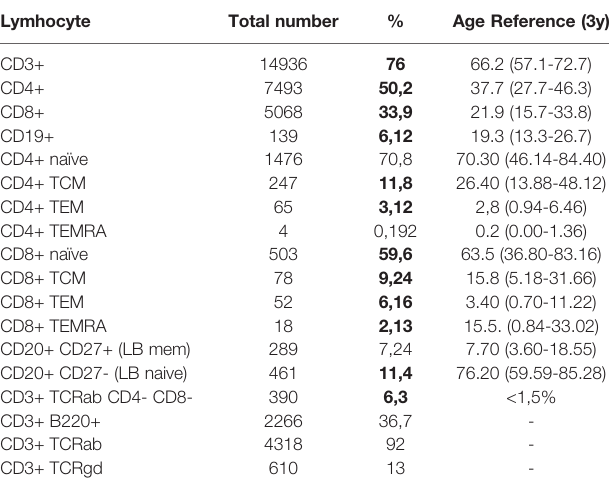
In bold are the aberrant expressions when compared tothe reference range. As expected in SIFD disease, marked low levels of B (CD19 cells) can be observed and an unusual observation of very high levels of double negative T cells (TCR a / b ).